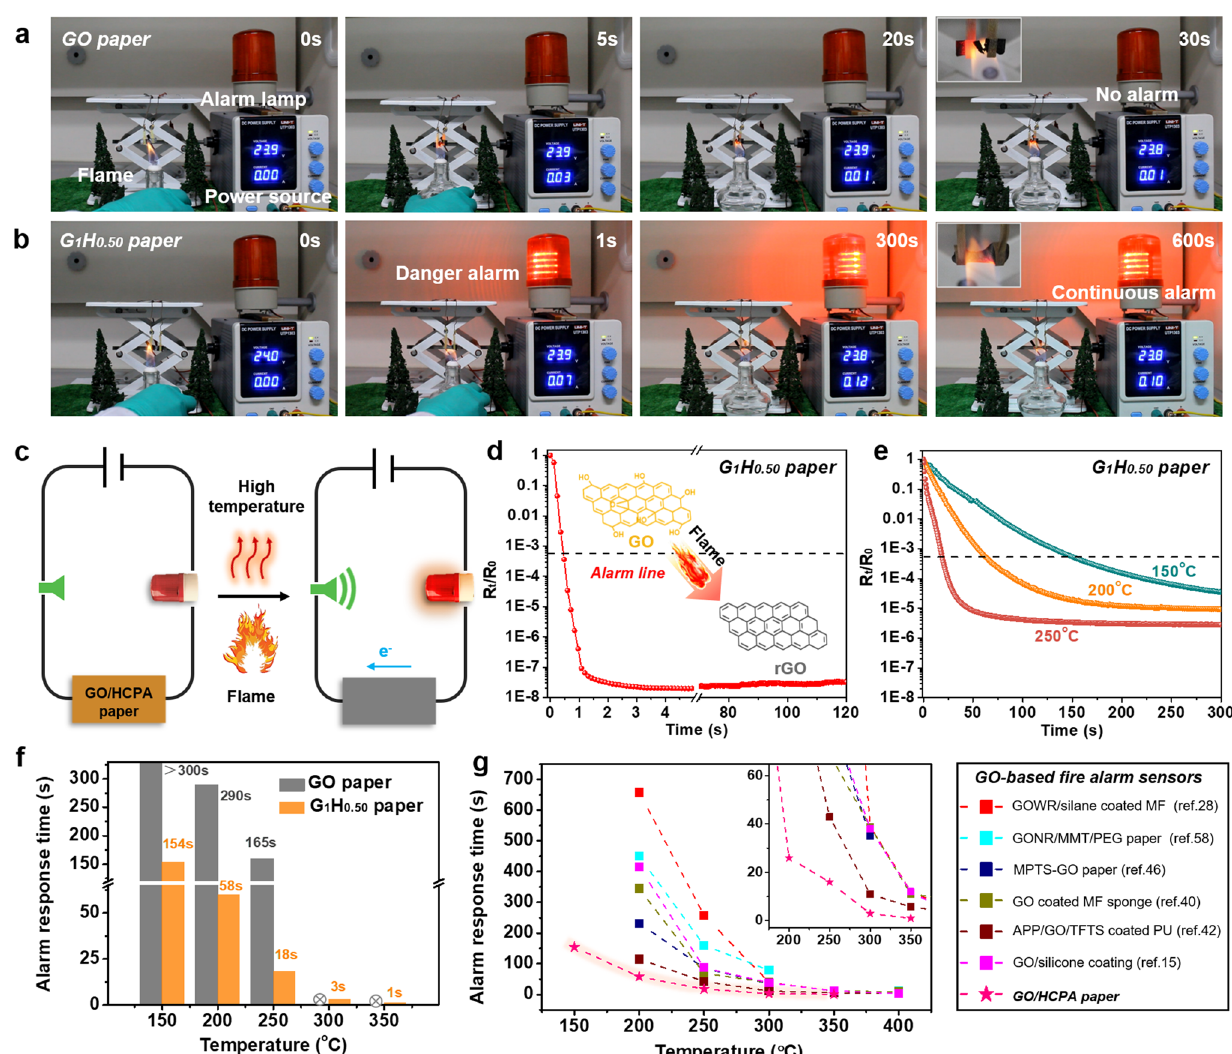
Fig. 4 Flame detecting and early alarm response performance. Photographs of flame detection processes of a GO paper and b G 1 H 0.50 paper; c schematic illustration of fire alarm sensor based on GO/HCPA paper under flame attack or high‑temperature condition. Electrical resistance transition behaviors of the